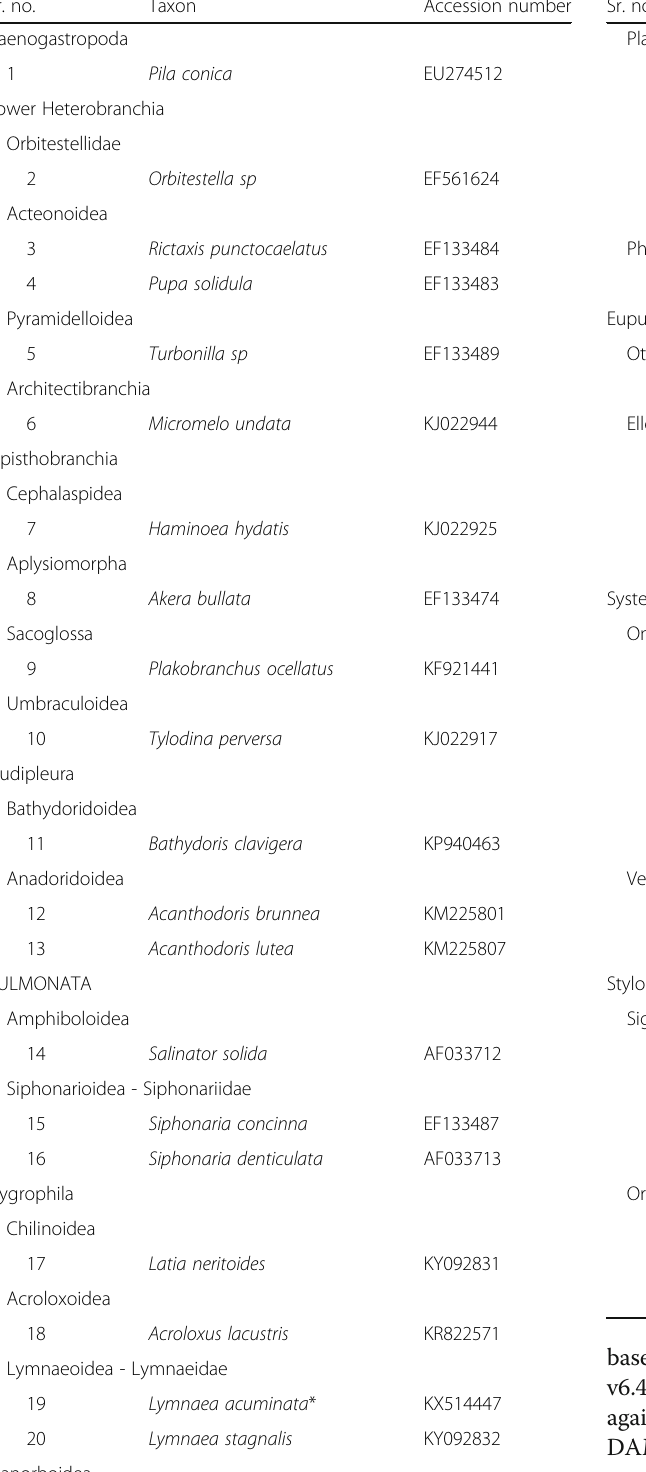
Table 1 List of taxa utilized in the present study (including the taxa sequenced in the present study — marked by asterisk), taxonomic position, and accession numbers (Continued) Sr.